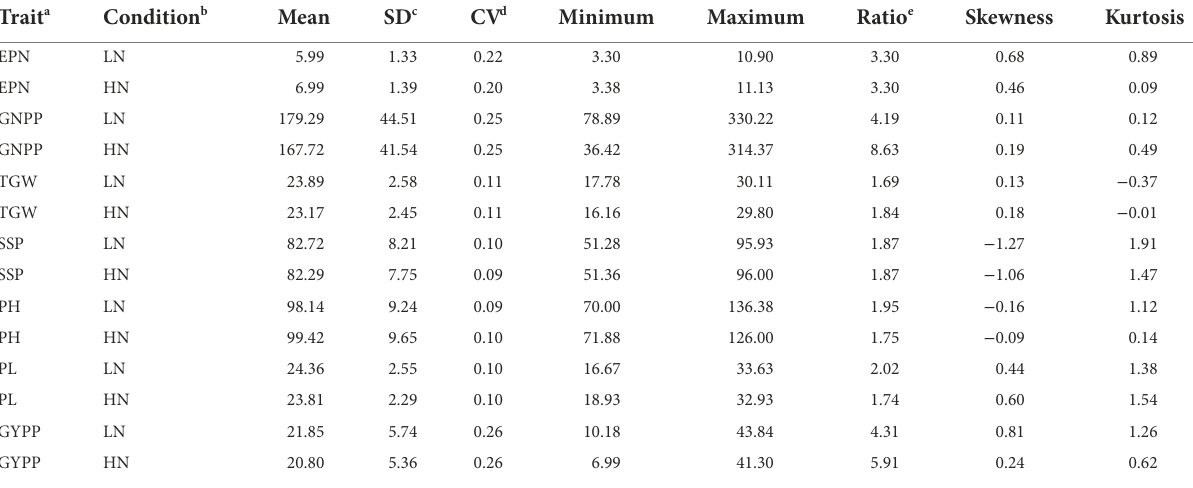
TABLE 1 Summary of seven agronomic traits of the RIL population under different N levels. Trait